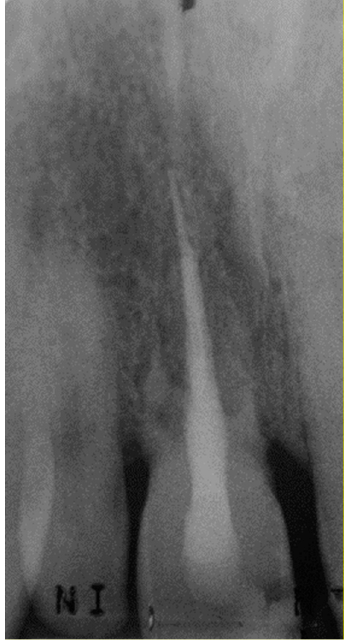
Figure 9. Rx at the 10-year recall visit.